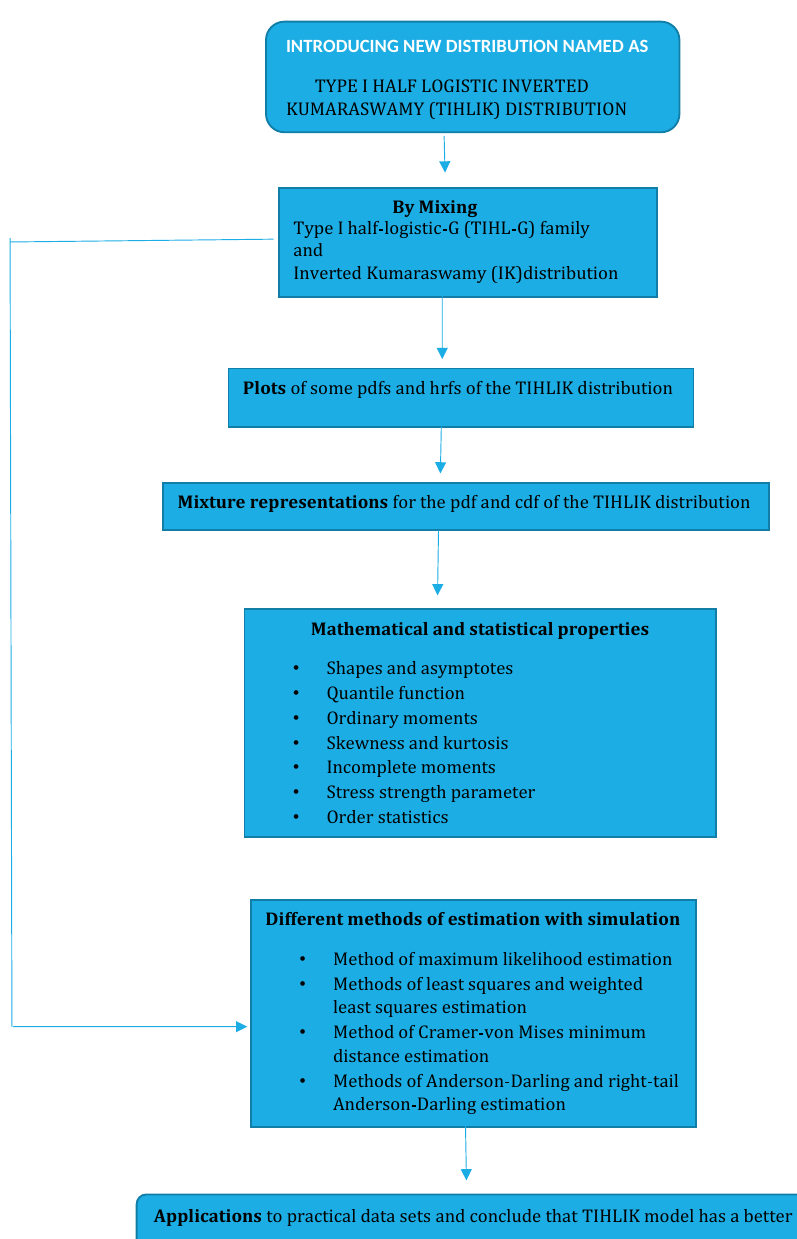
Figure A1. Diagram summarizing the methodology and the main lines of the